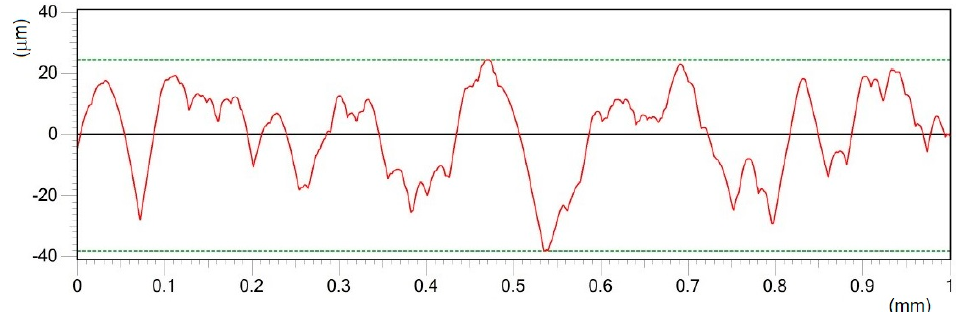
Figure 10. Roughness profile of surface E in Y direction, treated by pulse energy of 1 mJ; Ra 11.73 μ m.